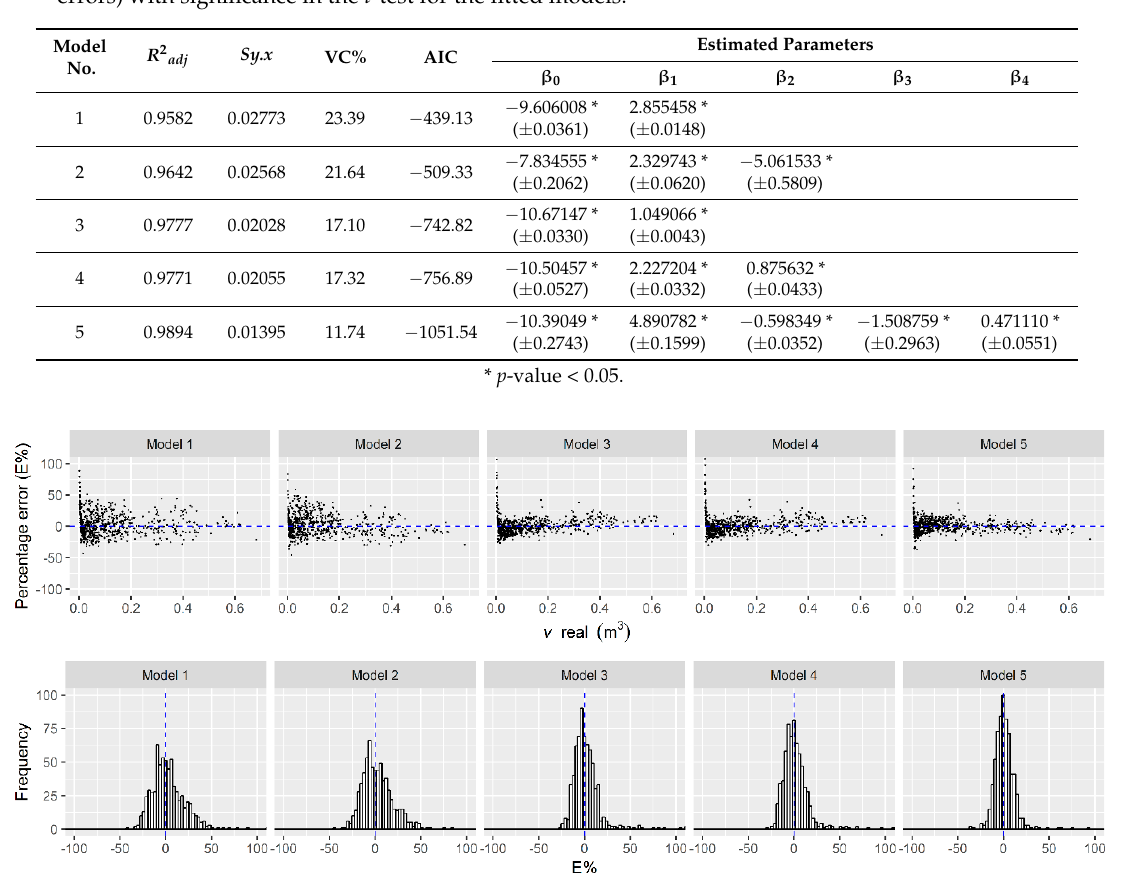
Figure 5. Percentage error vs. real commercial volume with bark up to 4 cm in diameter at the tree top ( v ) and frequency histogram of E% of the fitted models.